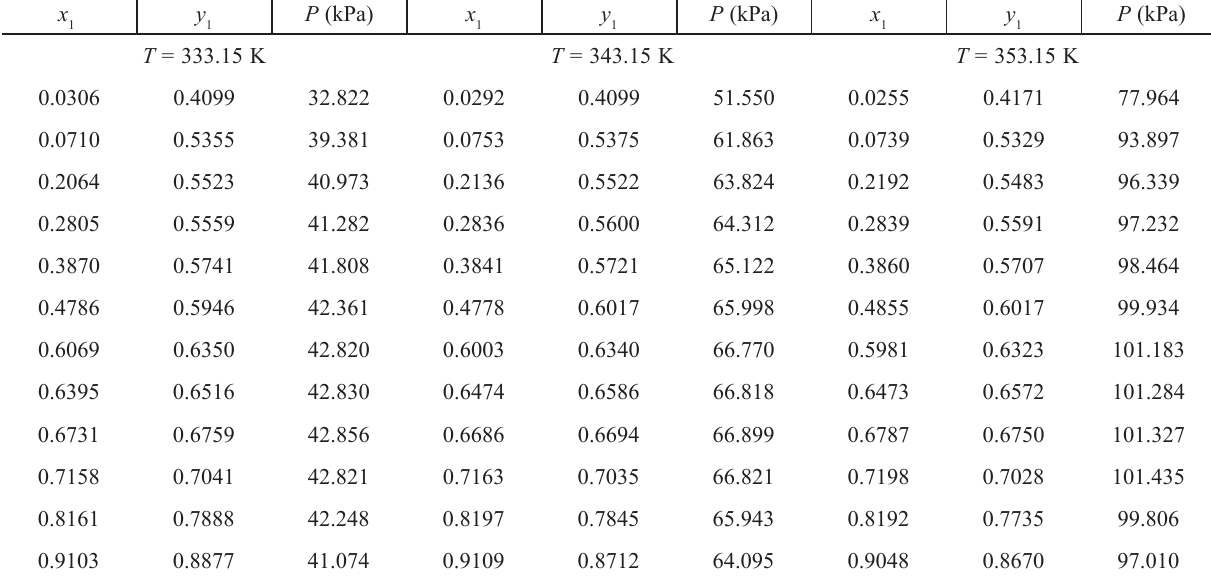
Table 2 – Vapor-liquid equilibrium in the 2-methylpropan-2-ol + water (2) system x